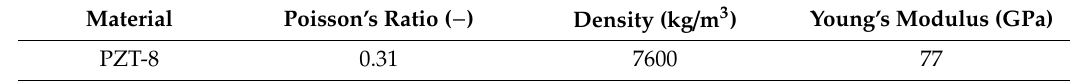
Table 1. Parameters of piezoelectric